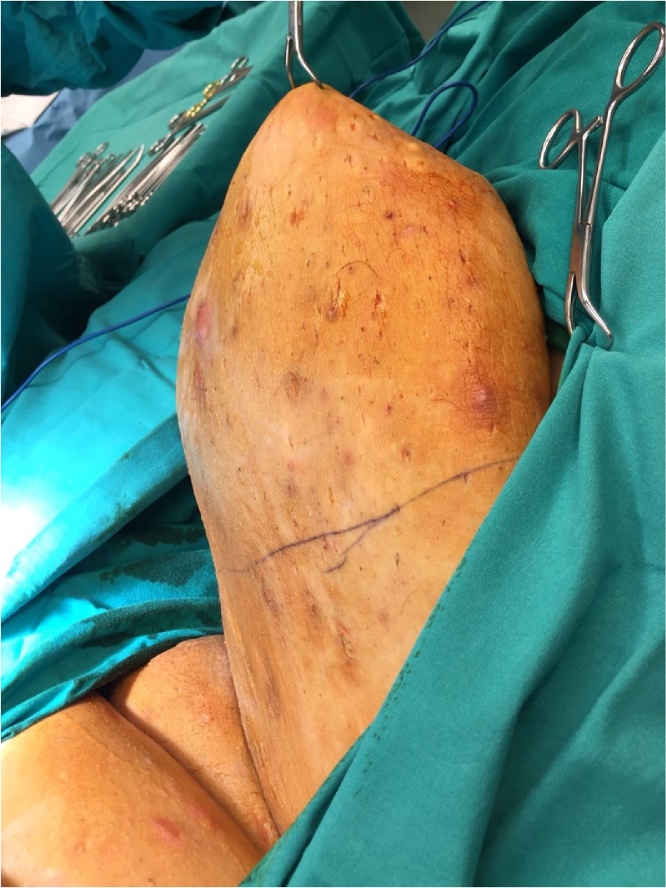
Tc-99m-MIBI scintigraphy detected an ectopic adenoma located in the lower anterior mediastinum, on the left of the median line.